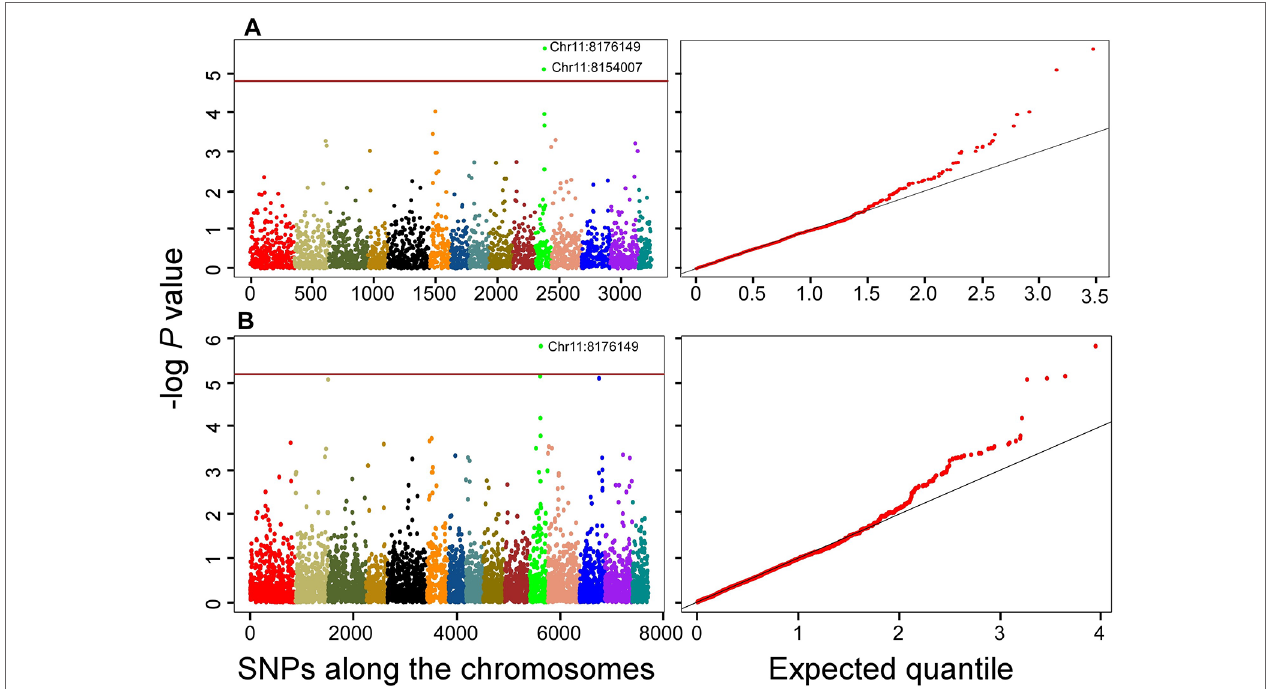
FIGURE 5 | Manhattan and quantile-quantile plots showing QTNs that are significantly associated with shoot dry weight using the stringent Bonferroni criterion for both datasets; (A) 3K dataset; (B) 7K data set. The horizontal brown lines indicate the threshold P = 0.05/n = 0.05/3243 = 1.54178E-05 and 0.05/7707 = 6.48761E-06 for the 3K and 7K datasets, respectively. Position of the significant QTNs on chromosome 11 are indicated. Colors in Manhattan plot indicate the 15 chromosomes of flax in order from 1 to